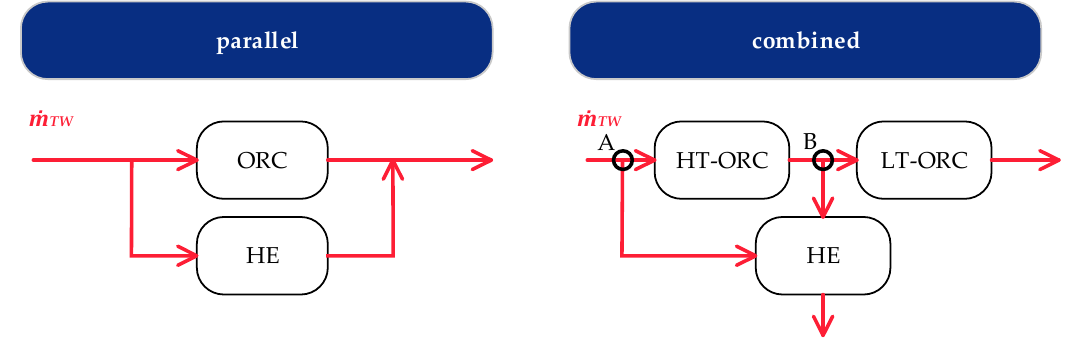
Figure 3. Schematic diagram of the parallel and the combined heat extraction concepts.